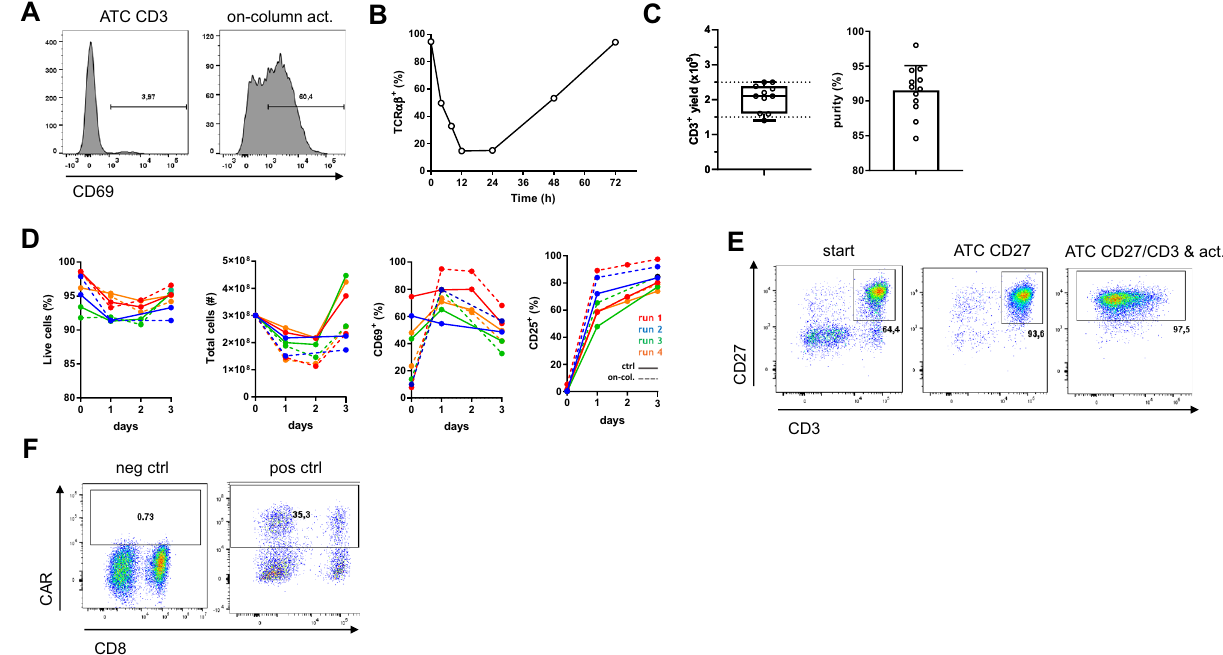
Figure 5. Integration and automation of ATC system with other manufacturing-relevant operations. ( A ) On-column stimulation with Expamers leads to T cell activation. Target cells captured on CD3 selection matrix were left unstimulated or stimulated by addition of Expamers and culture media to the selection column and incubation at 37 °C for 4 h. Collected cells were analyzed using flow cytometry. Cells were pre-gated on live, single CD45 + lymphocytes. Histograms depicting expression of CD69 activation marker from one out of 12 experiments are shown. ( B ) TCR/CD3 complex is downregulated upon activation. Graph shows TCR expression kinetics up to 72 h after an ATC CD3 selection with on-column activation. Graph represents data from one experiment. ( C ) A predictable number of target cells can be captured under saturating conditions. Graphs show CD3 + cell yield and purity of several ATC CD3 single column selections. Graph summarizes data from 11 independent measurements. Bars and boxes represent mean ± SD. ( D ) Comparison between ATC CD3 selection with either simultaneous or subsequent T cell stimulation. Kinetic of viability, cell proliferation and expression of early and late activation markers. Collected cells were counted and analyzed using flow cytometry. Cells were pre-gated on live, single CD45 + lymphocytes. Graphs show cumulative data from 4 experiments. ( E ) On-column activation of CD3 + CD27 + T cells. CD3 + CD27 + T cells were isolated using ATC CD27/CD3 double positive selection followed by on-column stimulation. Representative dot plots are shown. ( F ) Example of on-column activation and downstream transduction. Selected, stimulated and subsequently transduced (pos ctrl) or not (neg ctrl) T cells were analyzed for CAR transgene expression after 5 days of culture using flow cytometry. Cells were pre-gated on live, single CD45 + lymphocytes. Dot plots depicting expression of CAR receptor from one out of 3 independent experiments are